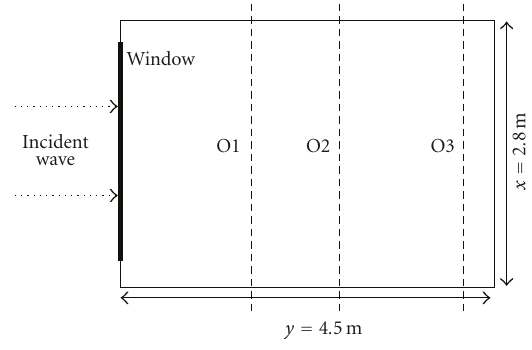
Figure 7: A satellite-to-mobile/indoor